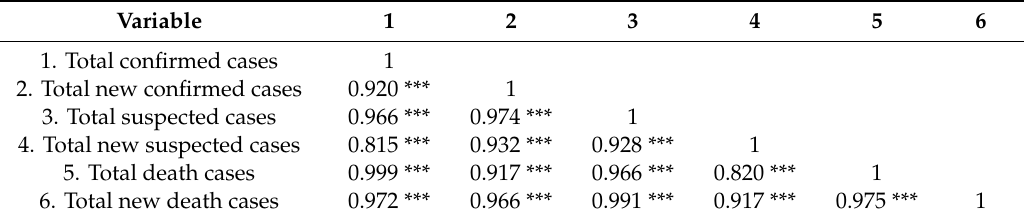
Table 5. Correlation coe ffi cients among six